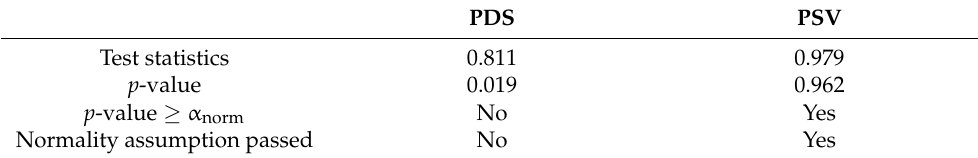
Table 5. Verification of data normality assumption using the SW test, α norm = 0.05.